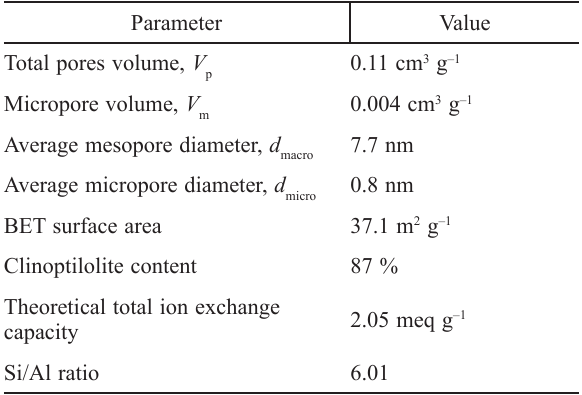
Table 1 – Physicochemical characteristics of natural zeolite